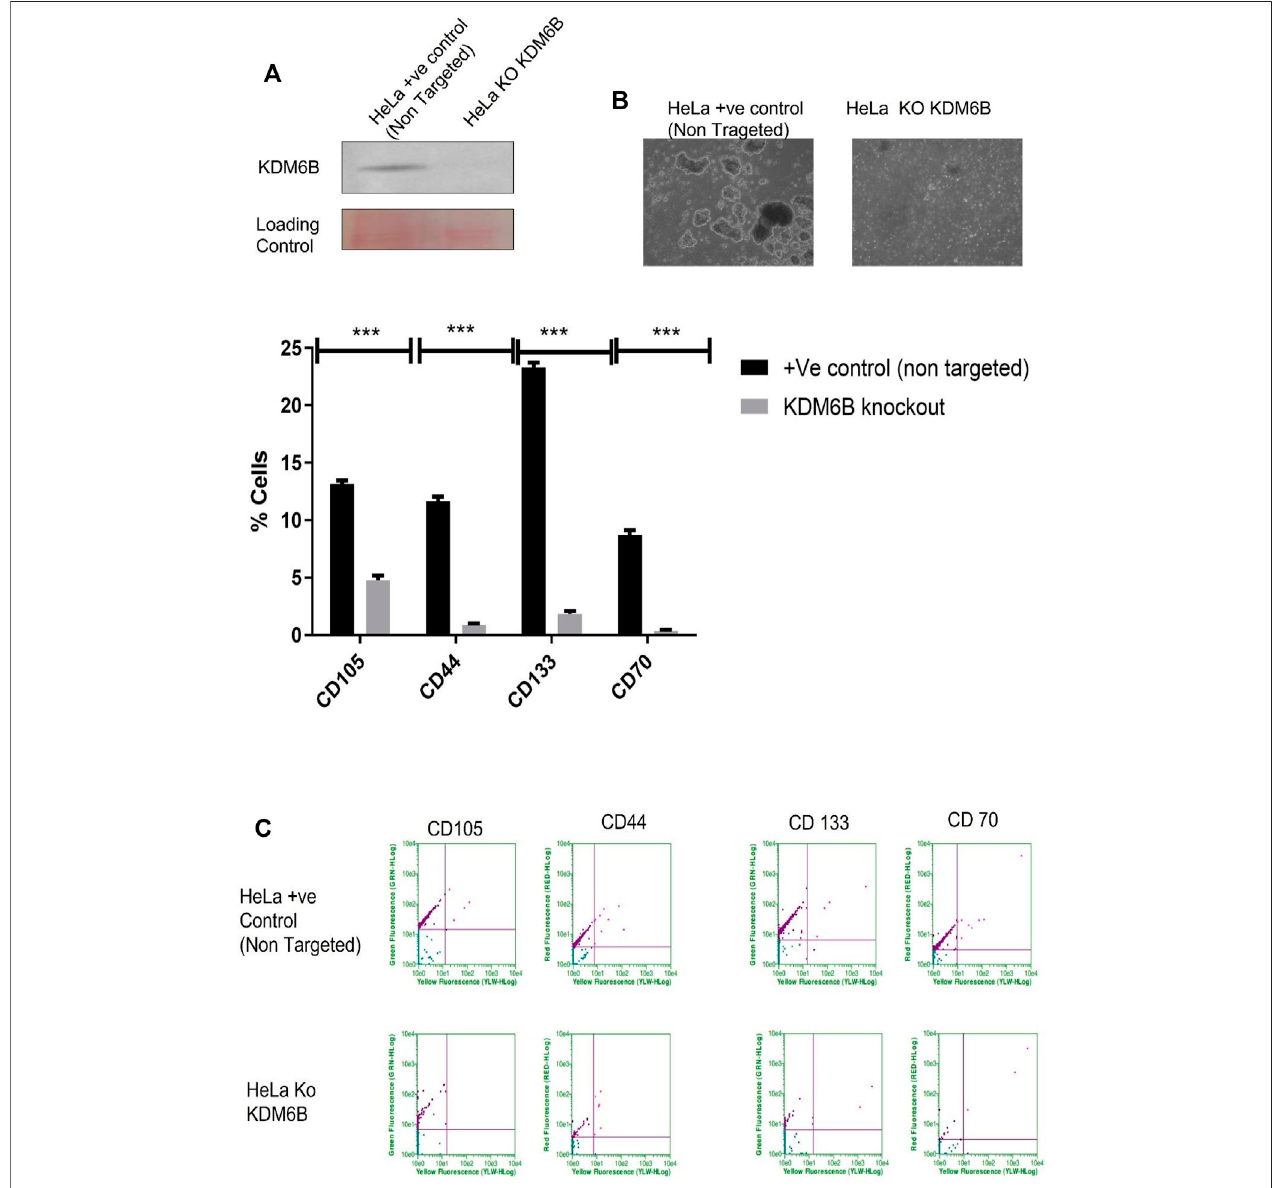
FIGURE 5 | CRISPR knockout KDM6B and reduce stemness in ECM-detached cells. (A) Total protein was isolated from +ve control empty CRISPR Cas- transfected cell line and CRISPR KDM6B-knockout cell lines. Western blot was performed as previously mentioned, and the blot was probed with anti-human KDM6B antibodies; the loading control was blot stained with Ponceau staining. (B) Sphere formation assay HeLa + ve Control (non-targeted) and HeLa KDM6B-knockout cell lines were cultured in matrix detachment for six days. At the end of the treatment schedule, sphere images were captured by using a Nikon inverted light microscope. (C) HeLa+veControl(non-targeted)andHeLaKDM6B-knockoutcelllineswereculturedinmatrixdetachmentforsixdaysintheendfortimeduration.The fl ow cytometry – based expression of various surface markers of stemness was measured.